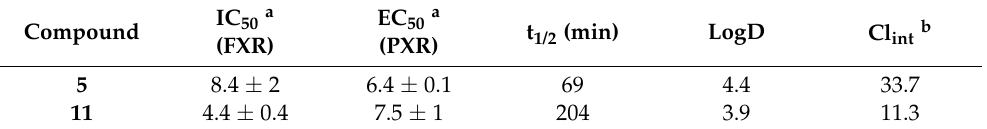
Table 2. Potency and physicochemical properties of compounds 5 and 11 .